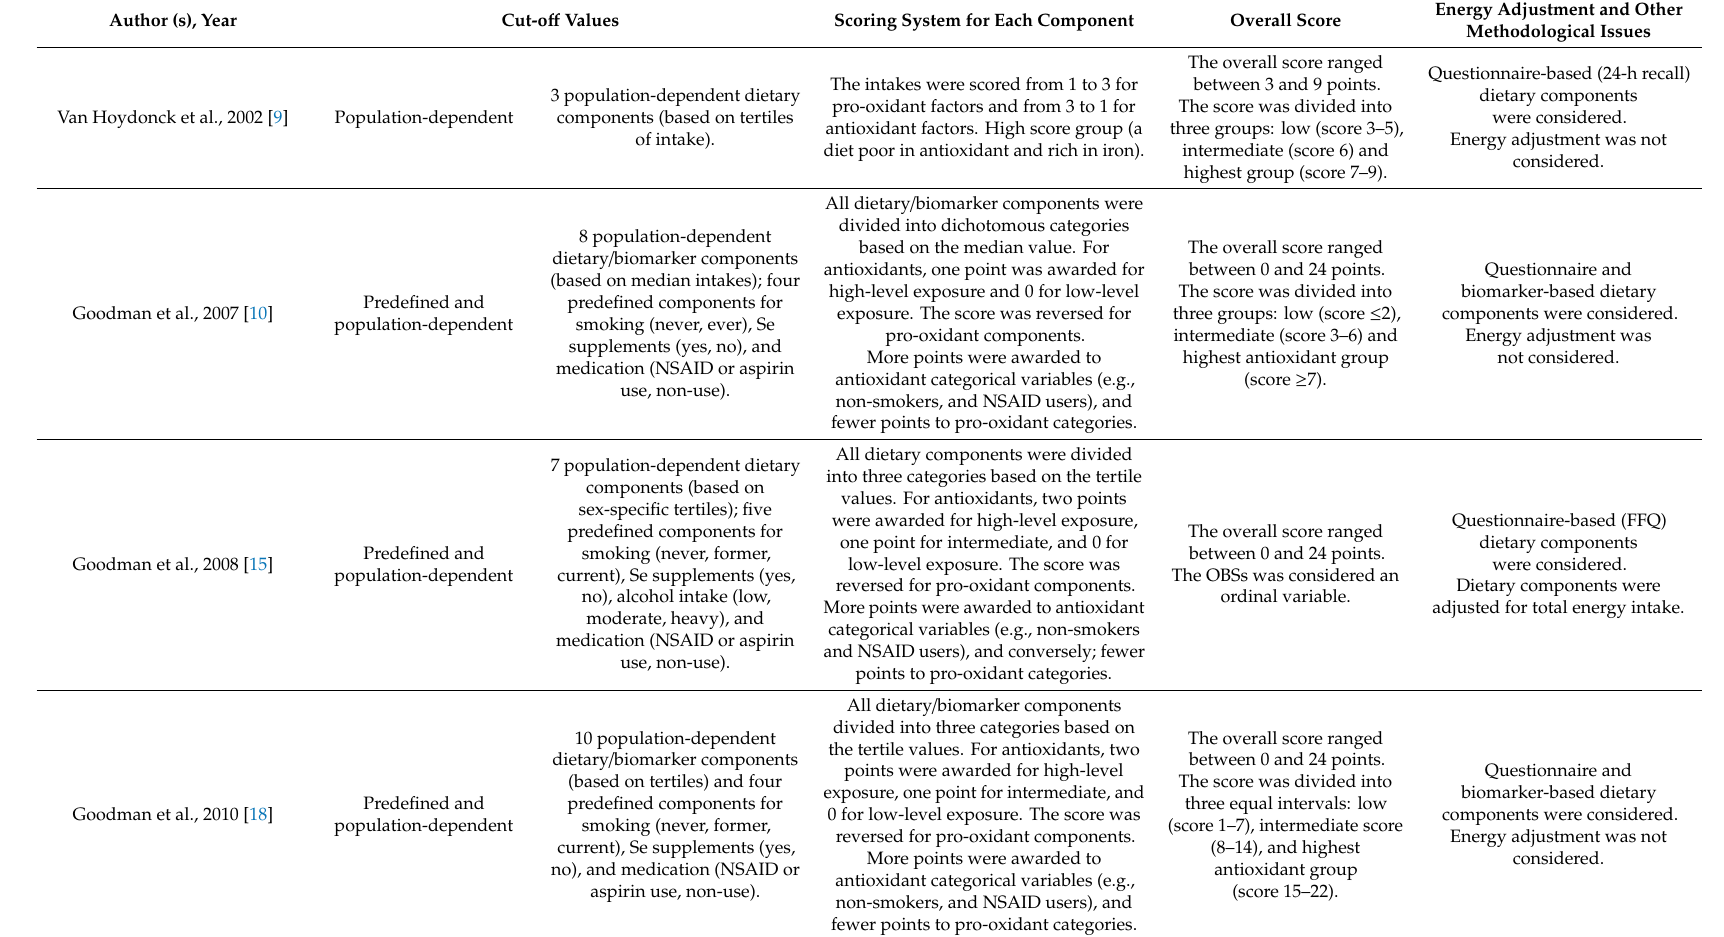
Table 5. Methodological criteria of the Oxidative Balance